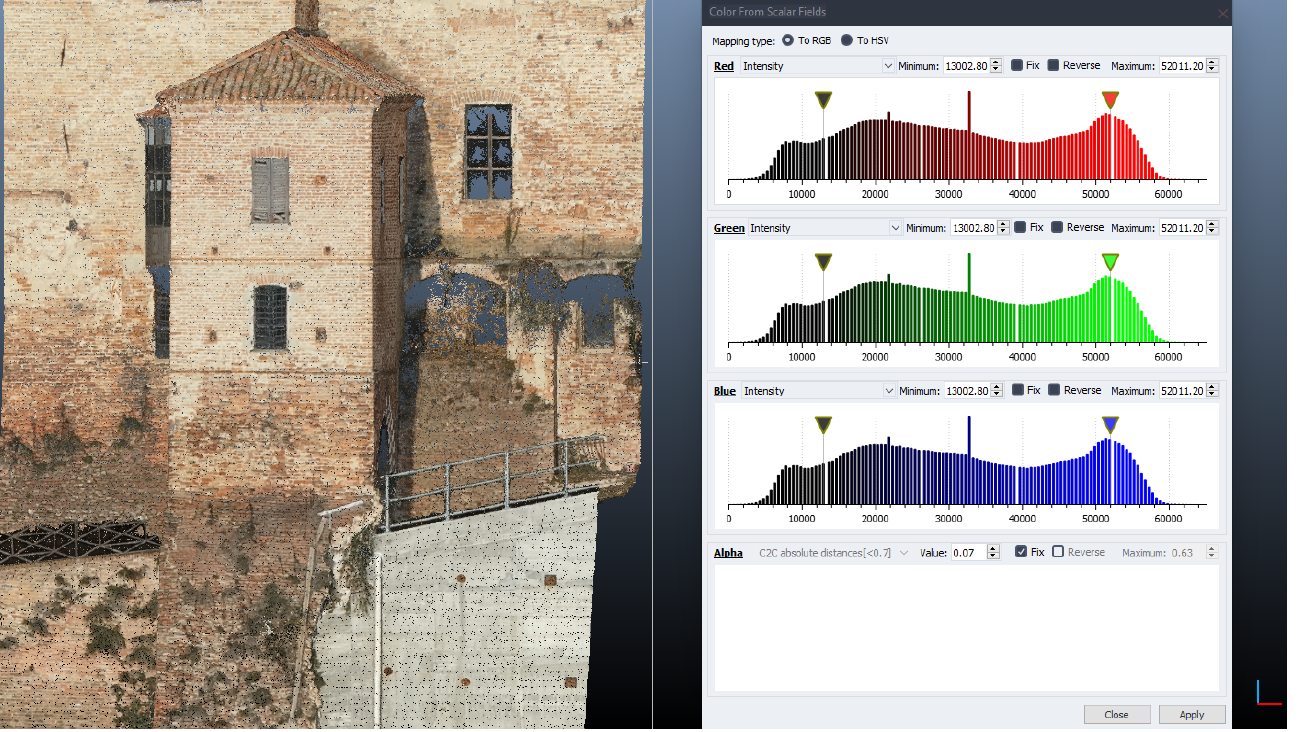
Figure 30. Radiometric values and red, green, and blue spectra related to the photogrammetric point clouds of the entrance